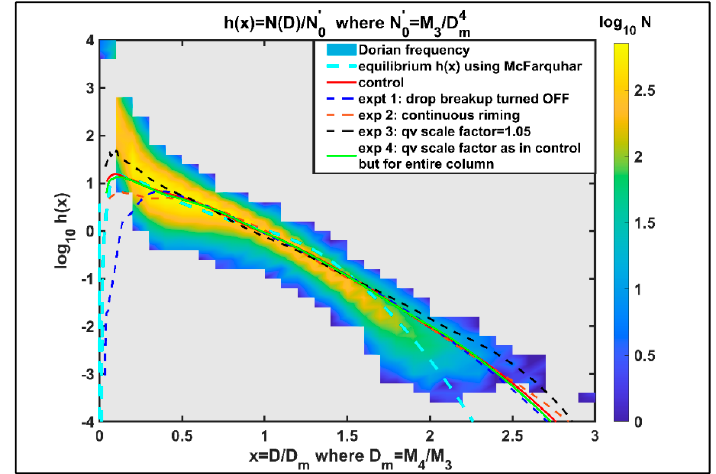
Figure 8. The double moment normalized distributions from all the 3 ‐ min averaged N(D) from the disdrometers shown as a frequency of occurrence plot. The continuous solid and dashed lines are from control and experiments 1–4. The equilibrium h(x) is also shown for reference obtained from the equilibrium N(D) from [29] as implemented in McSnow.